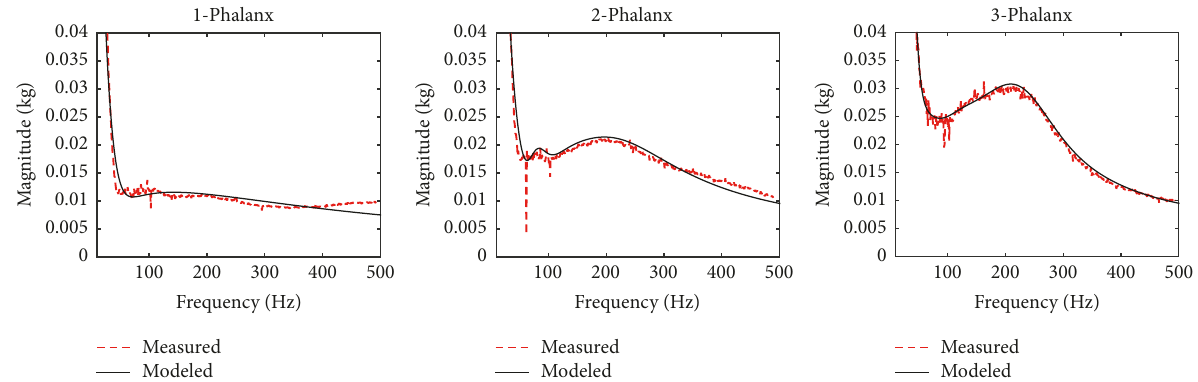
Figure 10: Detailed comparisons of the modeled and measured AM magnitude for all three finger